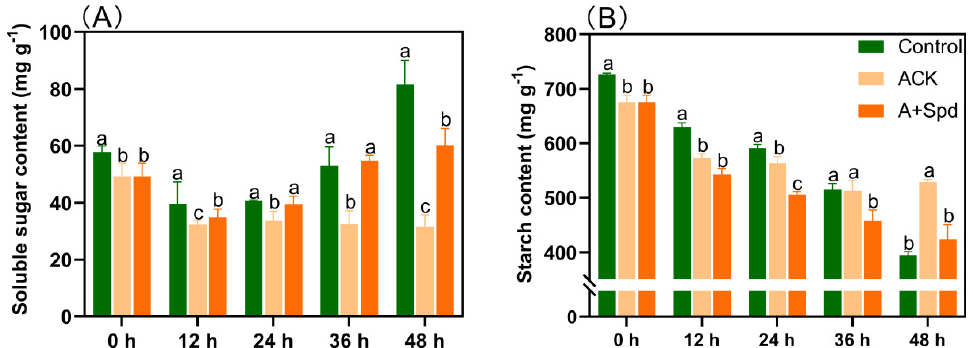
Figure 2. Effects of exogenous Spd on soluble sugar ( A ) and starch ( B ) at the germination stage of aged sorghum seeds. Control − healthy seeds; ACK − artificially aged seeds; A+Spd − aged seeds with Spd treatment. A total of five time points from 0 to 48 h after germination were performed for each treatment, and the different lowercase letters above the bars indicate significantly different levels among the treatments ( p < 0.05, Lsd). A 0.05 μ M concentration of exogenous Spd was used.